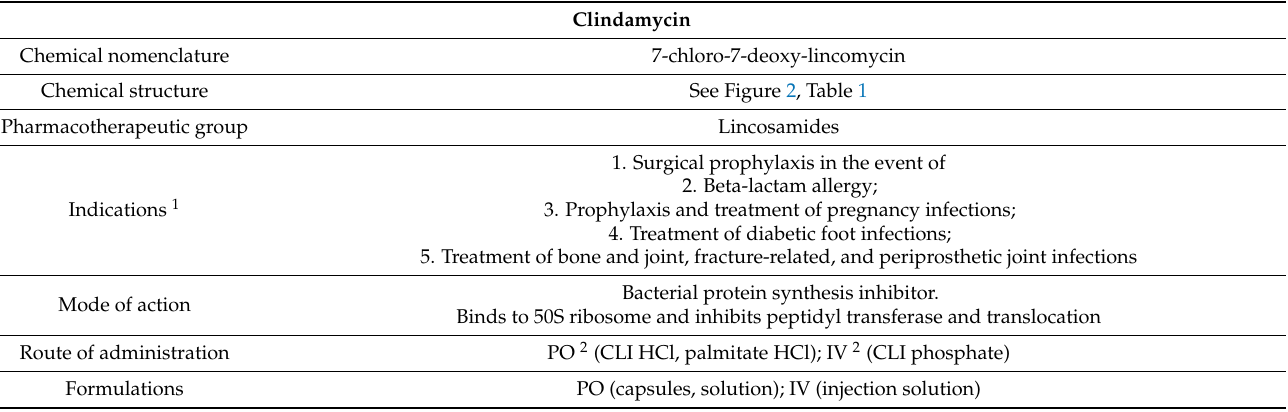
Table 2. Summary Table of clindamycin